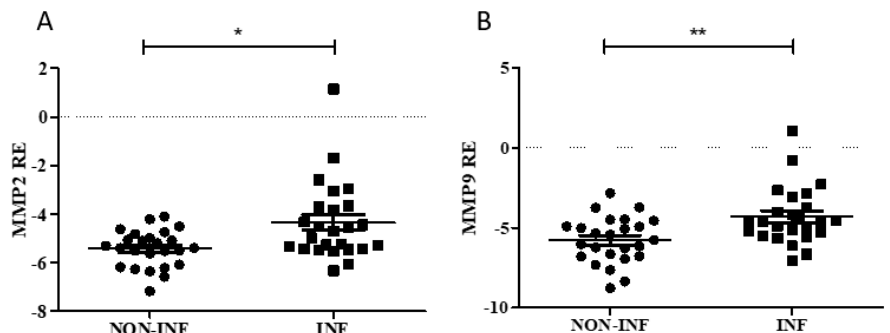
Figure 3. MMP (matrix metalloproteinase) levels in colon biopsies of IBD pediatric patients. MMP2